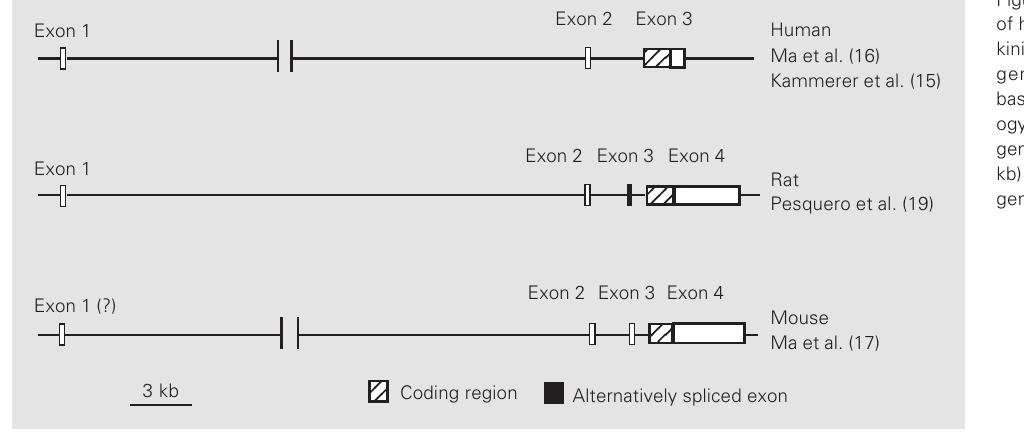
of human, rat and mouse brady- kinin B2 receptors. The mouse gene structure is proposed based on the sequence homol- ogy to exons 2 and 3 of the rat gene. The length of intron 1 (25 kb) is only known for the rat gene